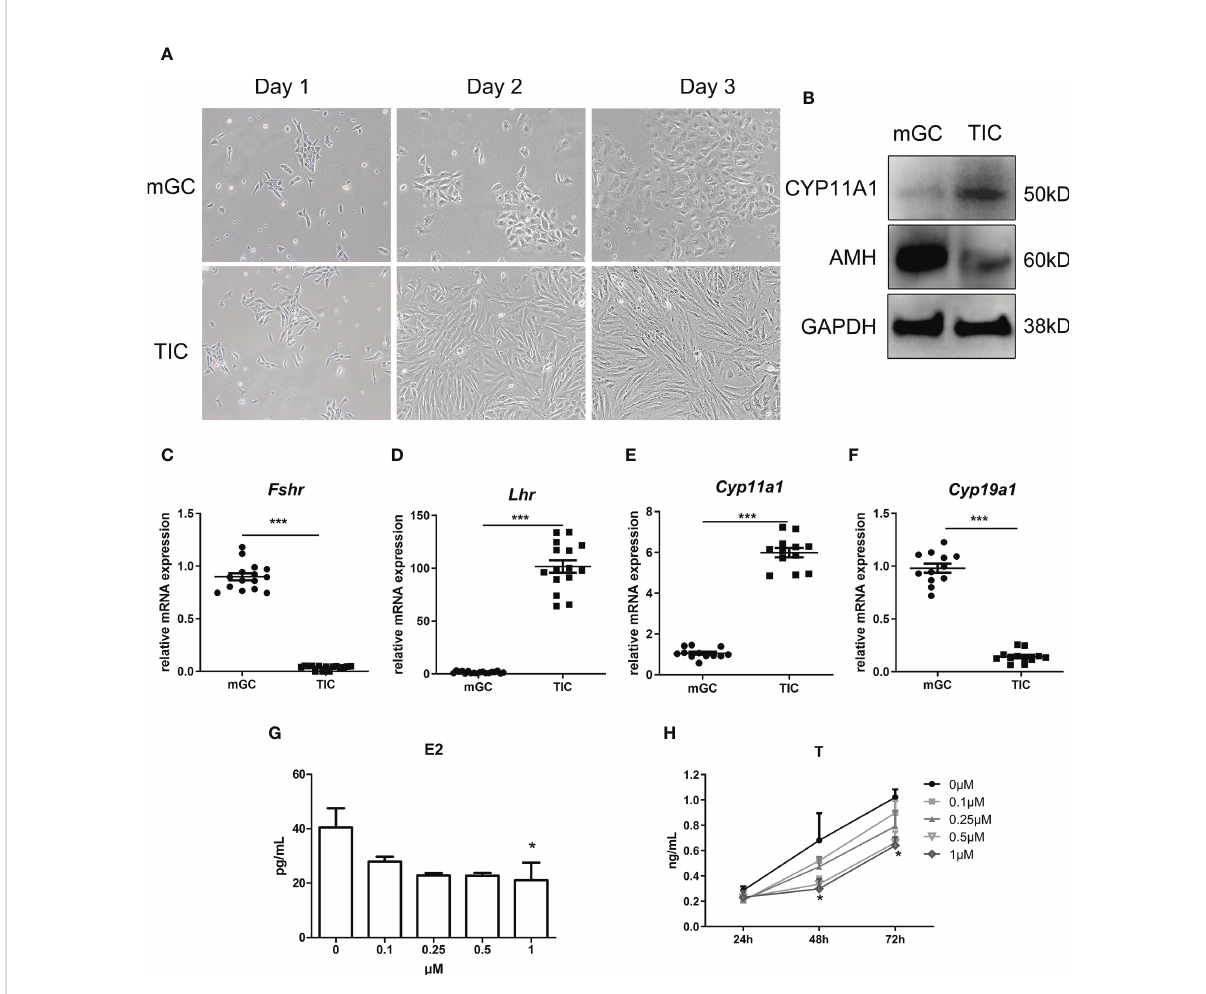
FIGURE 3 Identi fi cation of mGC and TIC and the in fl uence of CORTN on sex hormone secretion of the two cell types. Morphology of the primary cell was recorded for 3 days after isolation using an inverted microscope. (A) Protein and RNA were extracted from the cells. CYP11A1 and AMH protein expression of the two cell types were examined by Western blot. n = 3; t-test. (B) Relative mRNA expression of Fshr , Lhr , Cyp11a1 , and Cyp19a1 was examined by qPCR. n = 15; t-test. (C – F) mGC and TIC were treated with solvent or 0.1, 0.25, 0.5, and 1 µM CORTN, respectively. Cell culture supernatant of mGC after 72 h was collected to determine the concentration of E2 by ELISA. n = 3 with one repeat in each assay; one- way ANOVA. (G) Cell culture supernatant of T after 24, 48, and 72 h was collected to determine the concentration of T by ELISA. (H) *P < 0.05, ***P < 0.001 compared to group “ 0. ” n = 3 in each group at each time point with one repeat in each assay; two-way